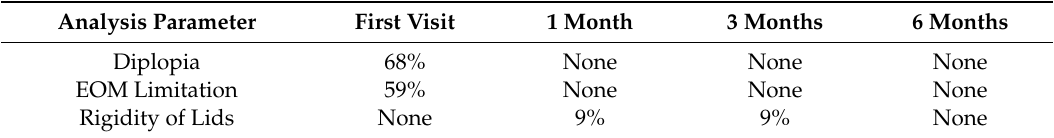
Table 6. The frequency of diplopia, lid rigidity and extraocular movements (EOM) restriction of patients treated with the titanium mesh and a collagen membrane (22